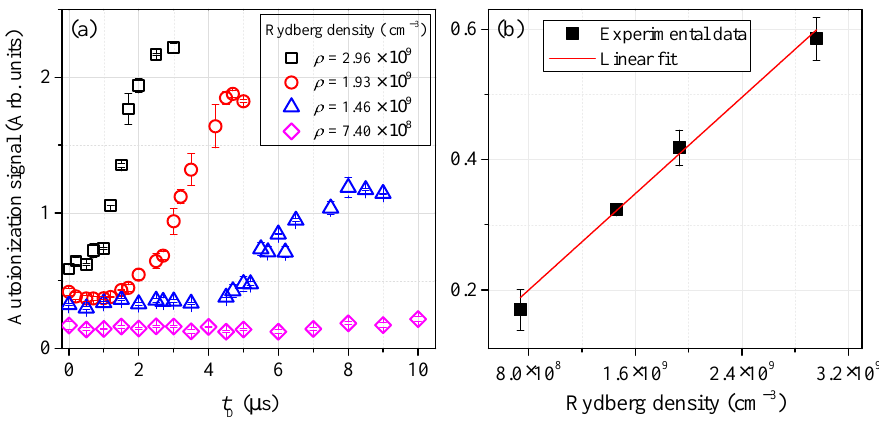
Figure 5. ( a ) Measured ion signals as a function of t D for an indicated Rydberg atomic density. ( b ) Measured autoionization signals at t D = 0 as a function of Rydberg atomic